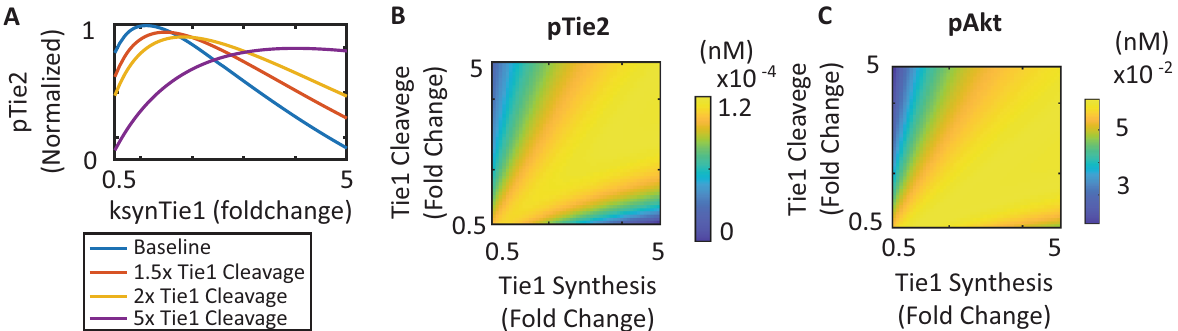
Fig. 8 Increase in Tie1 synthesis rescues Tie2 activation in in fl ammatory endothelial cells with high Tie1 cleavage. A Increase in Tie1 synthesis enhances and then inhibits activation of Tie2 when Tie1 cleavage is at baseline, 1.5-fold, or 2-fold of its baseline value; when Tie1 cleavage is at 5-fold its baseline value, an increase in Tie1 synthesis enhances the activation of Tie2. Changes in the cleavage and synthesis rate of Tie1 affect the B phosphorylated Tie2 and C phosphorylated